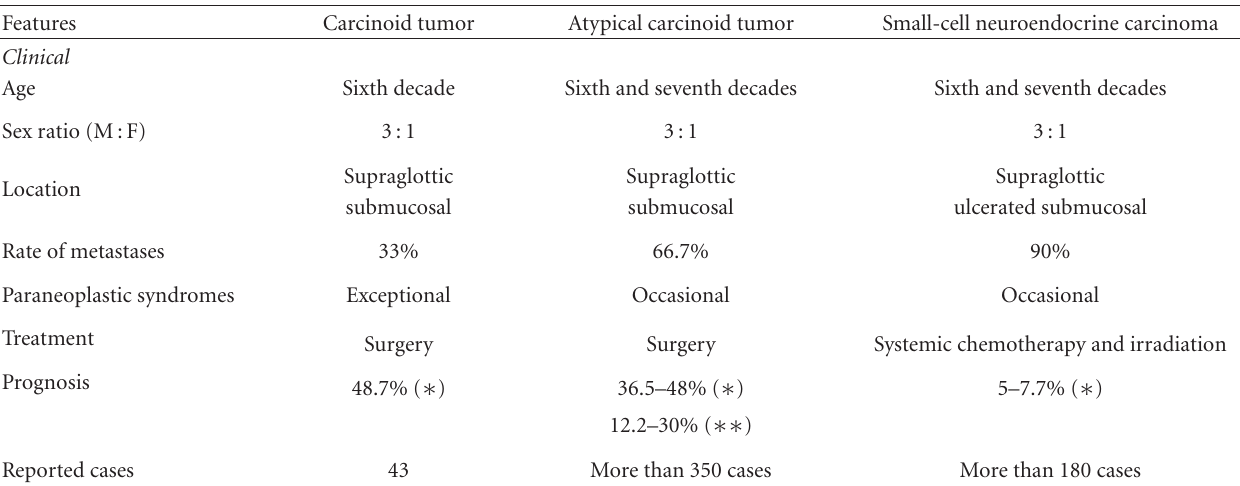
Table 2: Comparison of laryngeal neuroendocrine